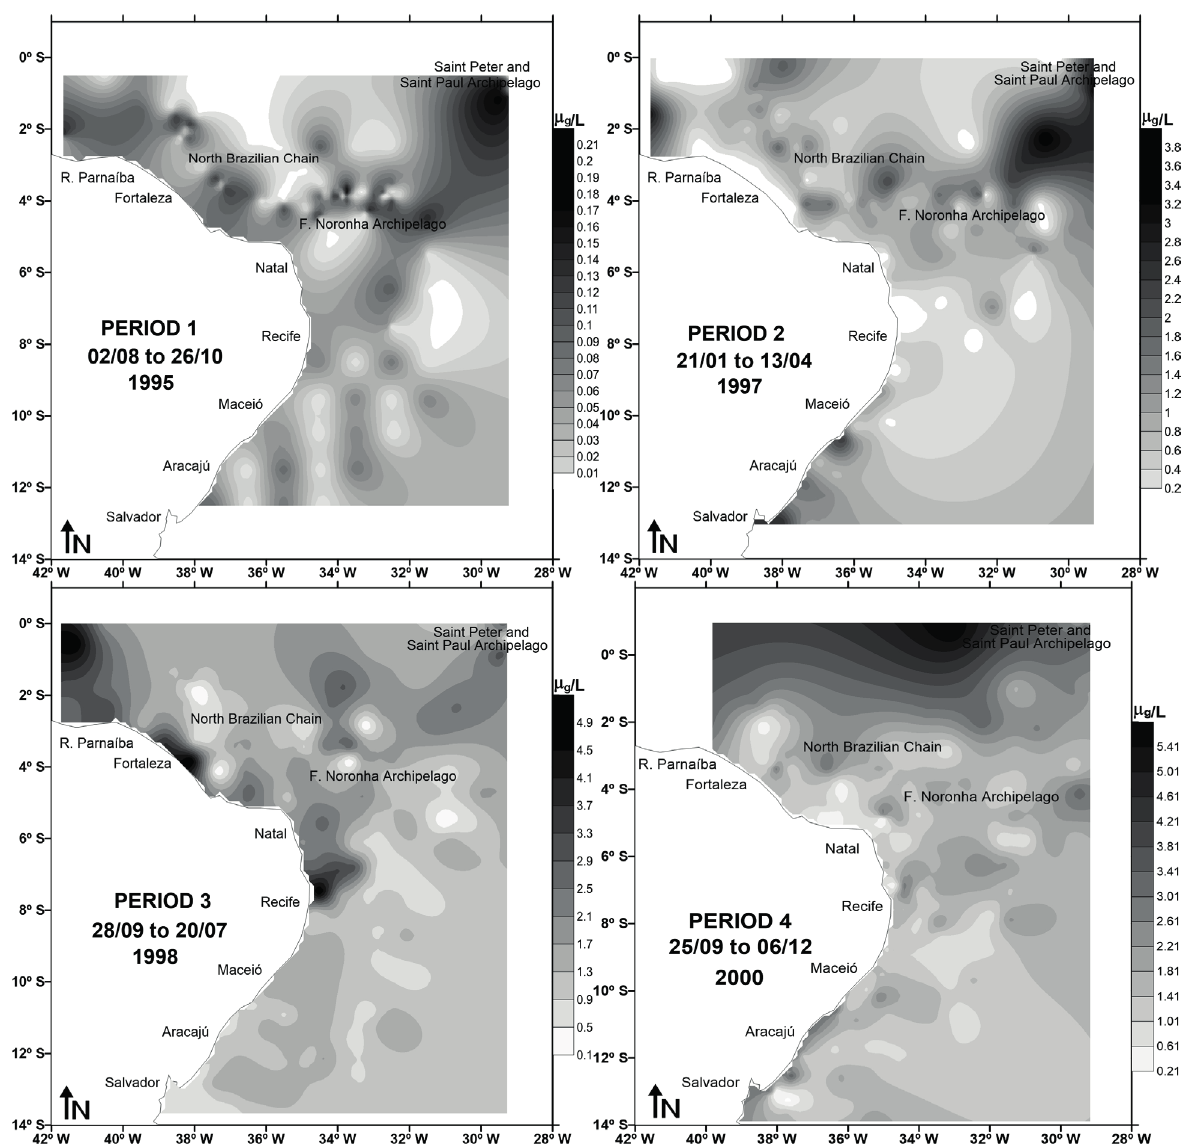
Figure 3 - Horizontal distribution of Chlorophyll a (mg l-1) at the 1% in the west tropical Atlantic